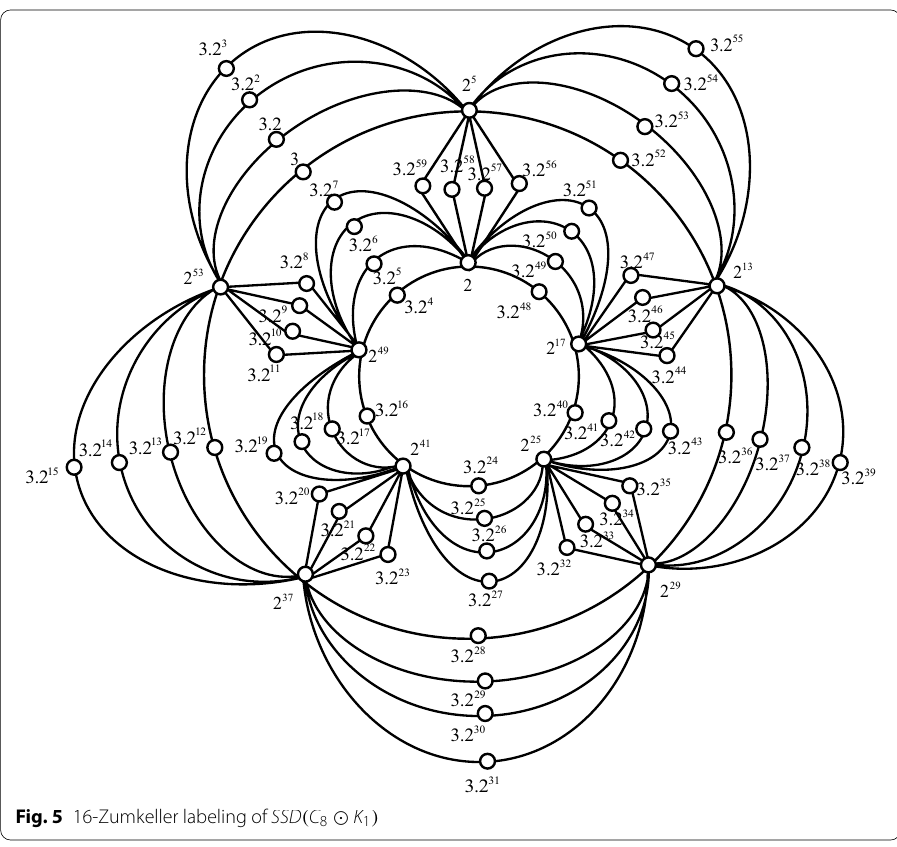
Fig. 5 16-Zumkeller labeling of SSD ( C 8 ⊙ K 1